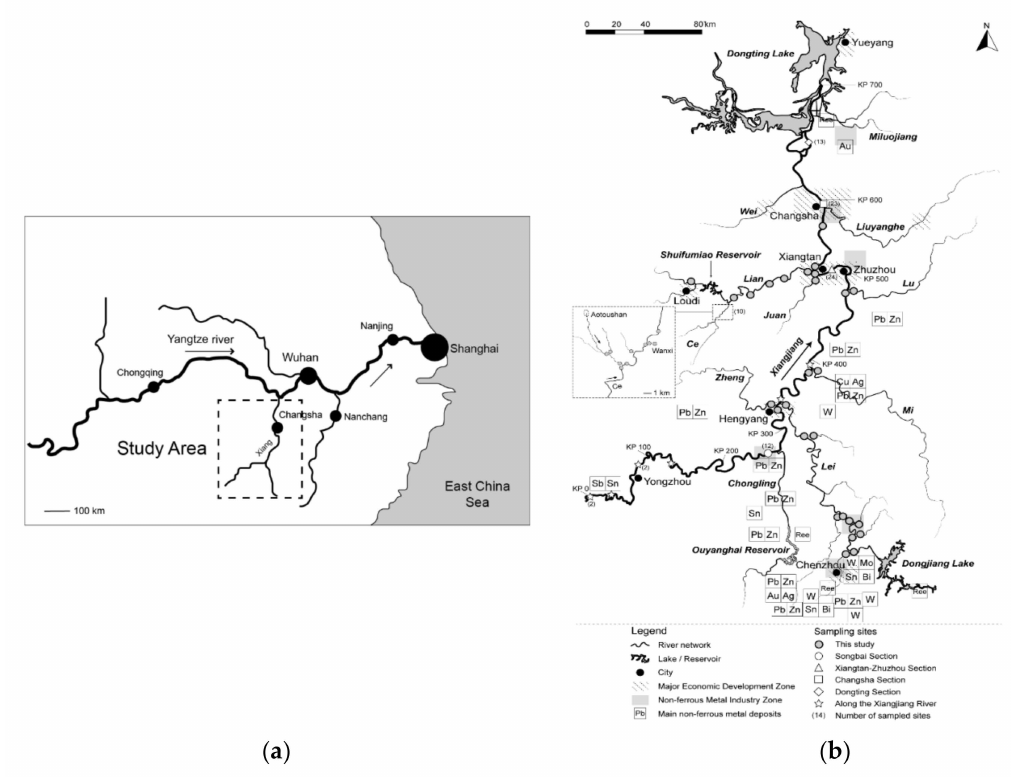
Figure 1. Study area in the Yangtze river basin ( a ) and sample localization ( b ) in this study and from the literature review used in this study. KP = kilometric point. Ferrous metals refer to Cr, Fe, Mn, Ti, V and their alloys, such as steel, pig iron, ferroalloys. Nonferrous metals refer to Al, Bi, Cd, Co, Cu, Hg, Ni, Pb, Sb, Sn, Zn. Localization information is detailed in Table